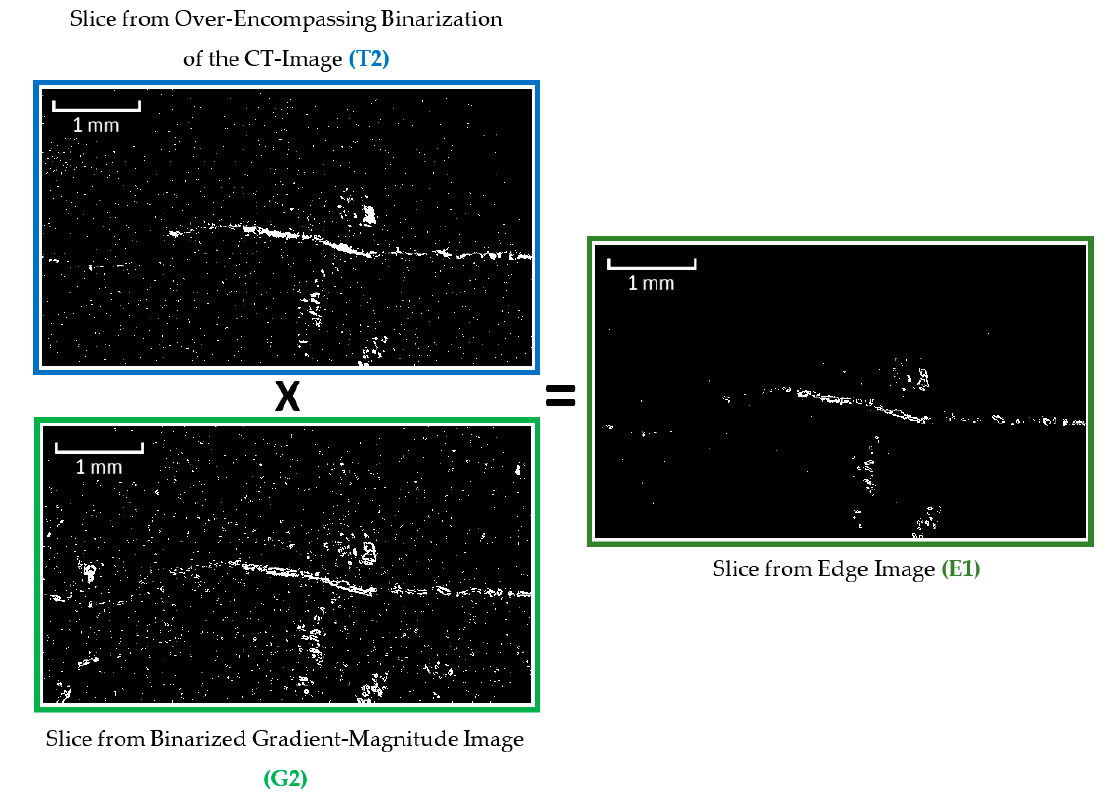
Figure 9. Generation of an image containing the outer edges of only low-density objects (based on figure in [10]).